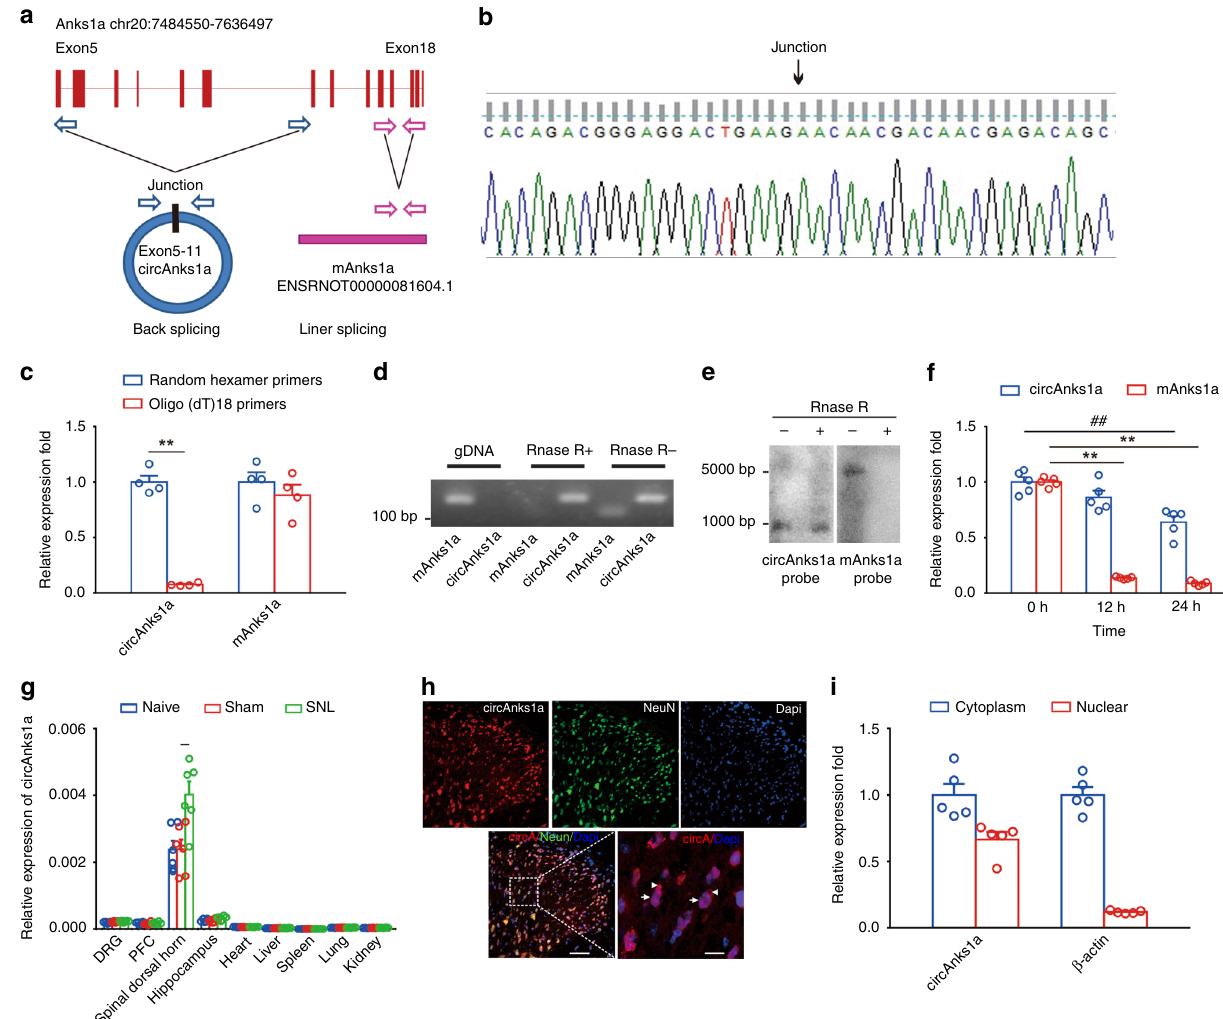
Fig. 2 Identi fi cation of circAnks1a. a Scheme illustrating the production of circAnks1a. CircAnks1a was formed by back splicing from exon 5 to exon 11 of the Anks1a gene. b The expression of circAnks1a was validated by Sanger sequencing. The arrow indicates the junction site of circAnks1a. c Random hexamer or oligo(dT) 18 primers were used in the reverse transcription experiments. The RNA levels were analyzed by qPCR and normalized to the value obtained using random hexamer primers ( ** P < 0.01 vs. random hexamer primers group, two-tailed two-sample t tests, n = 4). d PCR showed that dorsal horn circAnks1a, but not mAnks1a, was resistant to digestion by RNase-R ( n = 3). e Northern blotting showed that circAnks1a was detected by circAnks1a probes after RNase R treatment, while mAnks1a was not ( n = 3). f The relative RNA levels of circAnks1a and mAnks1a in the spinal dorsal horn were analyzed by qPCR at various time points after treatment with actinomycin D (i.t.) ( ** P < 0.01 vs. the mAnks1a group at 0 h, ## P < 0.05 vs. the circAnks1a group at 0 h, two- tailed one-way ANOVA, n = 5). g The expression of circAnks1a in nine different tissues was examined in naïve, sham and SNL-treated rats ( ** P < 0.01 vs. the sham group, two-tailed one-way ANOVA, n = 6). h FISH showed that circAnks1a was expressed in the nucleus (arrow) and cytoplasm (arrowhead) of spinal dorsal horn neurons. Left scale bar, 50 μ m; right scale bar, 10 μ m ( n = 3). i PCR results obtained after nucleus and cytoplasm separation showed circAnks1a was expressed in both the nucleus and the cytoplasm ( n = 5). The data are presented as the mean ± s.e.m. Source data is available as a